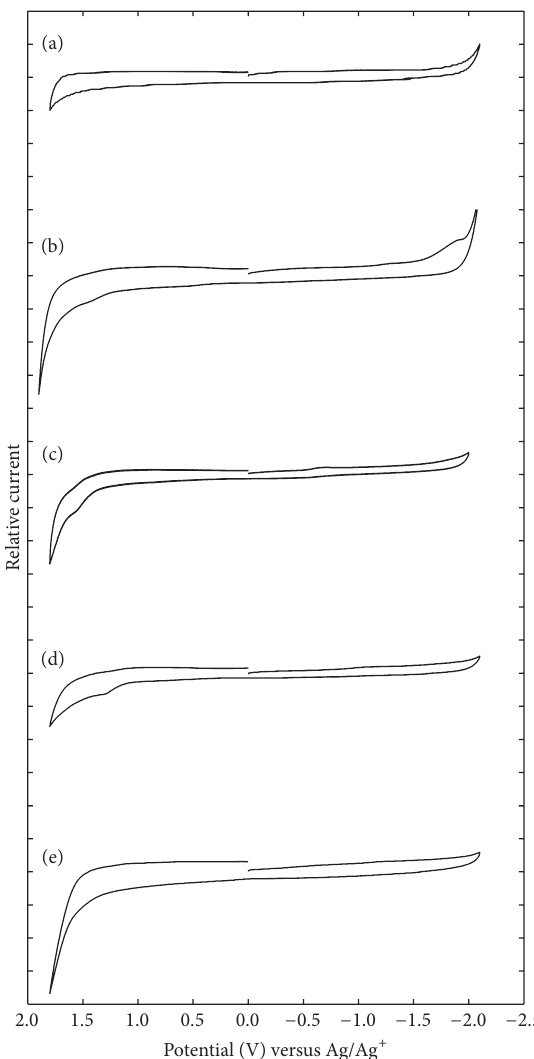
Figure 1: The cyclic voltammograms of porphyrin derived SWNTs and C 20 -SWNTs in the absence of ferrocenes in CH 2 Cl 2 solution using [( t -Butyl) 4 N] + [ PF 6 ] − as supporting electrolyte. (a) Back- ground, (b) THHP-HHP-SWNTs , (c) THHP-HMP-SWNTs , (d) -SWNTs THHP ⋅ SWNTs , and (e) C 20